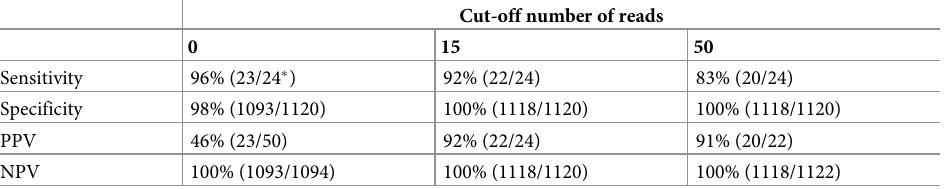
Table 5. Sensitivity and specificity of mNGS normalized reads for PCR target viruses. PPV: positive predictive value, NPV, Negative predictive value.